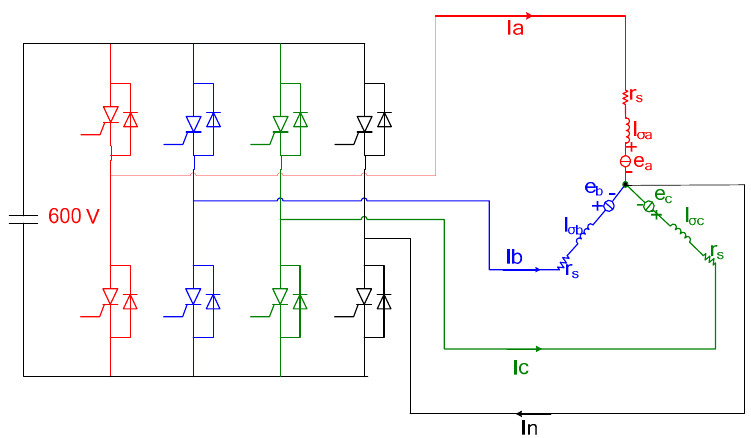
Figure 1. Four-leg permanent magnet synchronous motors (PMSM) drive.